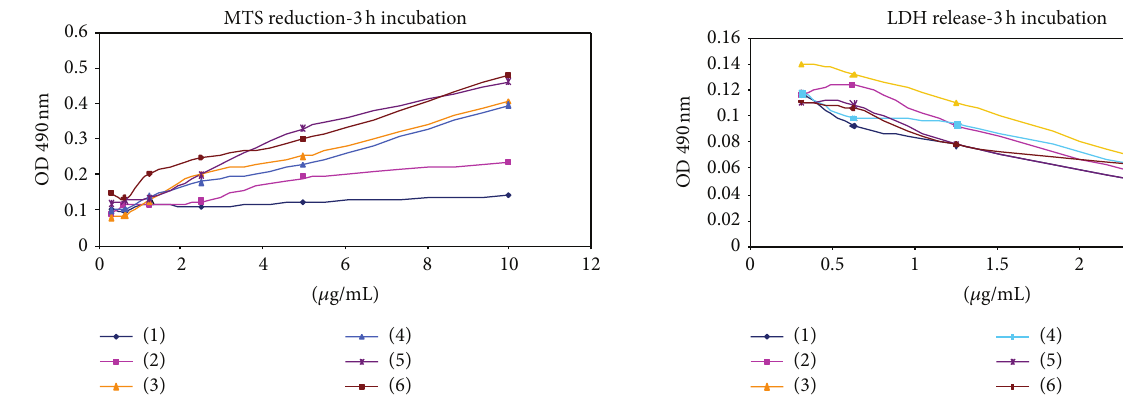
Figure 4: MTS assay, on Jurkat cell line, after 3 hours incubation at 37 ∘ C for samples (1)–(6): (1) TMHAPP; (2) THAPP; (3) MHTPP; (4) TMDOPP; (5) TMDPP; and (6) TRMDOPP.